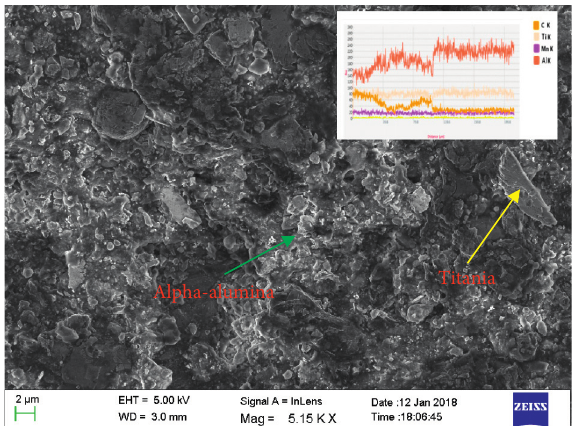
Figure 3: SEM micrograph of Al 2 O 3 +3wt%TiO 2 +5% CNTs reinforced composite coating surface with EDX.